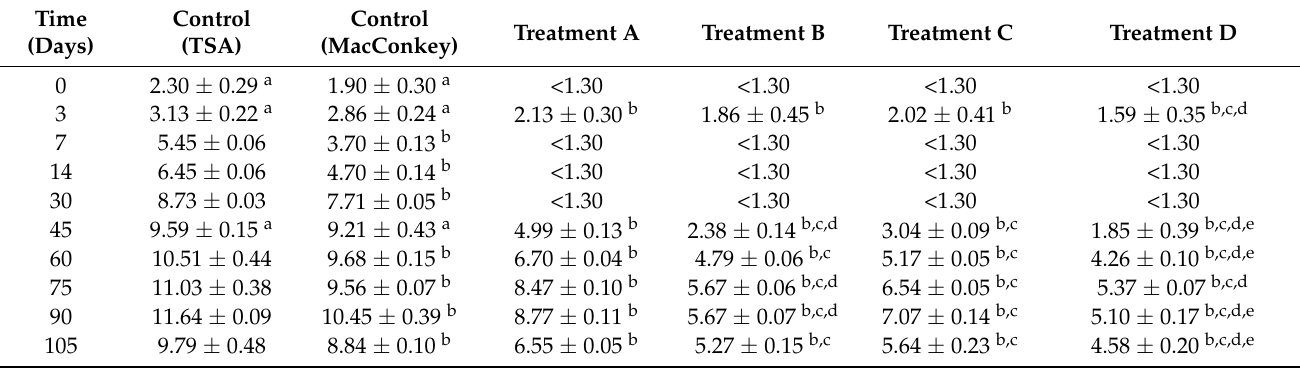
Table 2. Results obtained for trial 2. Viable cell counts (log CFU/g) obtained on non-selective and on selective media for the controls (cod heated at 52 ◦ C for 20 min) and for samples processed by different HP